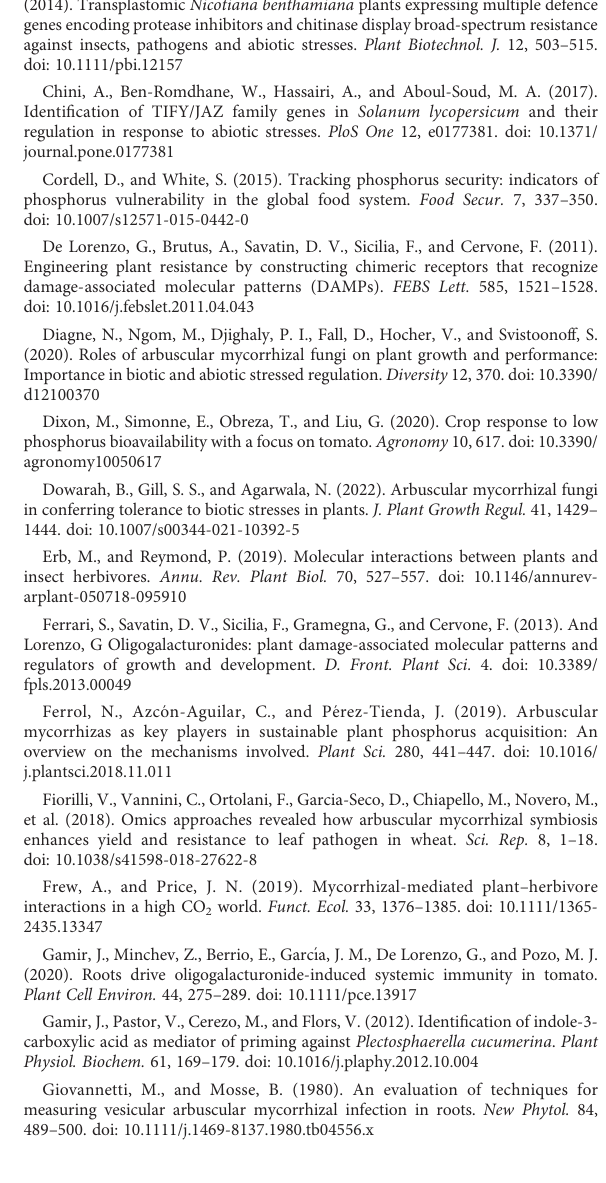
SUPPLEMENTARY TABLE 6 Multiway ANOVA of gene expression data. Effects of the different factors: effects are highlighted in bold. Asterisks indicate signi fi cant differences: +: p<0.1; *: p<0.05; **: p<0.01; ***: